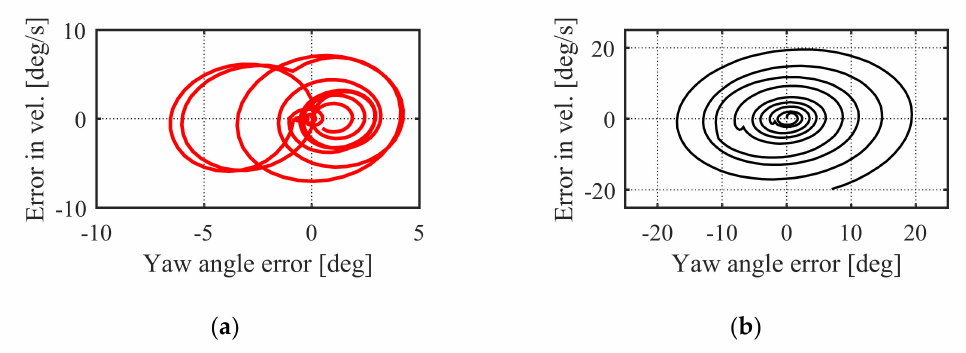
Figure 16. The phase-portrait in AM mode: ( a ) Proposed controller; ( b ) PID.